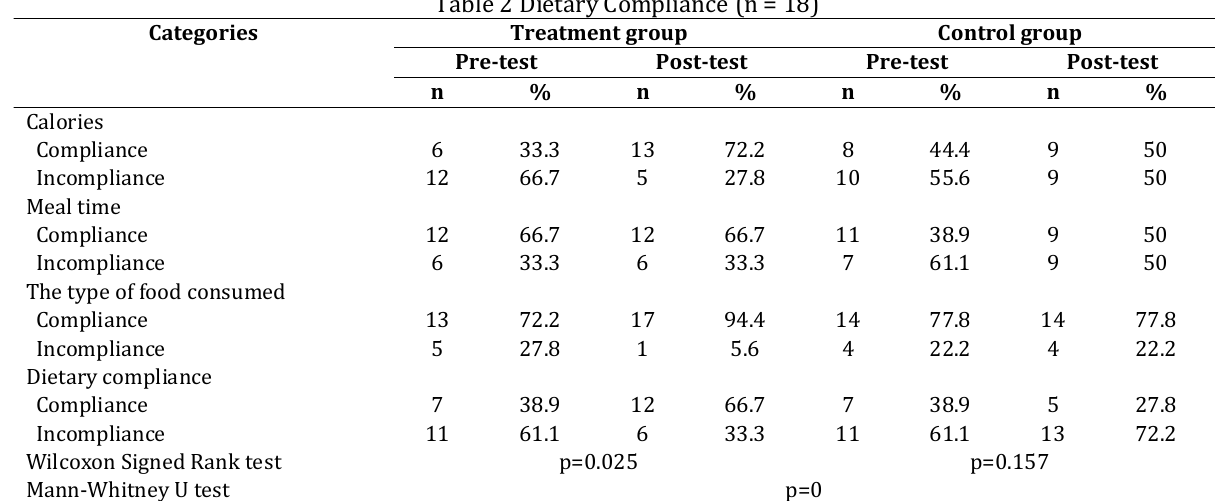
Table 2 Dietary Compliance (n =